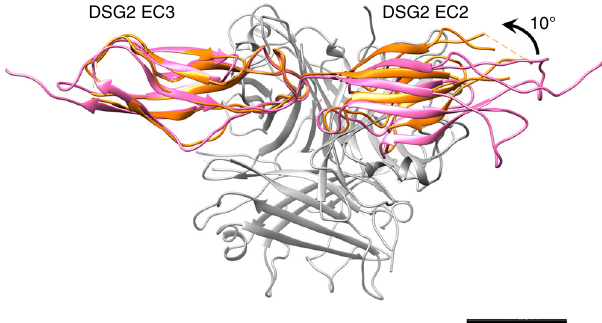
Fig. 4 Receptor cadherin domains twisting upon HAd3K binding. Superimposition of unliganded (in pink) and bound (in orange) EC2-EC3 to HAd3K (in grey) shows a 10° twist between EC2 and